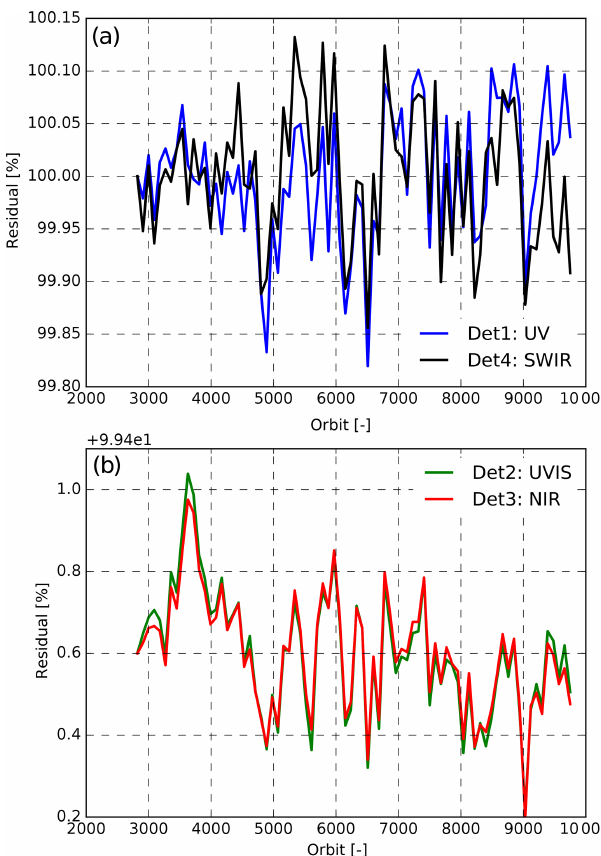
Figure 18. Normalized irradiance measurements for the SWIR de- tector for QVD1 (a) and QVD2 (b) . Signals are shown as row av- erages for three columns. The spread of signal values is large com- pared to the average change over time.